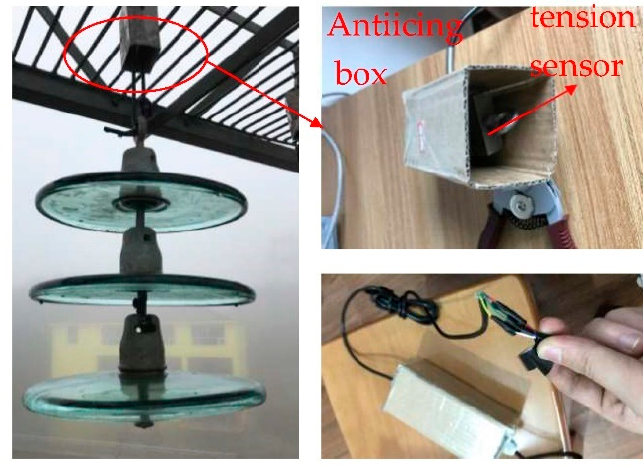
Figure 16. Field ice accretion figure of the rotating cylinder array.